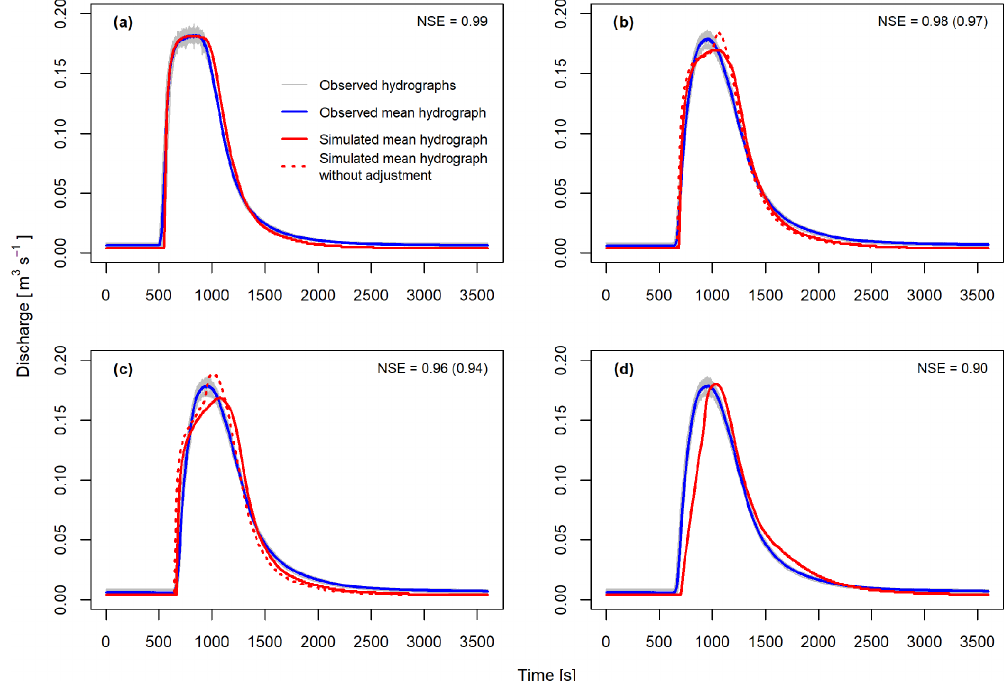
Figure 7. Best simulated mean flood hydrographs of all simulation variants with and without LW at Thomson weir 2: (a) results of the reference variant RV without LW, (b) variant V1 with stable LW as an increase of roughness in the entire channel, (c) variant V2 with stable LW as an increase of roughness at element positions only and (d) variant V3 with LW as discrete topographic elements of the calculation mesh. For simulation variants V1 and V2 the best fit with and without subsequent adjustment of riparian Strickler coefficients is displayed. The Nash–Sutcliffe efficiency (NSE) is shown for each simulation variant. If displayed, values in parentheses represent the NSE of simulations without adjustment of riparian roughness coefficients. Table 2. Calculated statistical goodness of fit parameters for all simulation variants. For variant V1 and V2 goodness of fit parameters with and without subsequent adjustment of riparian Strickler coefficients are displayed. Goodness of Reference Variant 1 without Variant 1 Variant 2 without Variant 2 Variant 3 fit parameters variant adjustment adjustment NSE 0.99